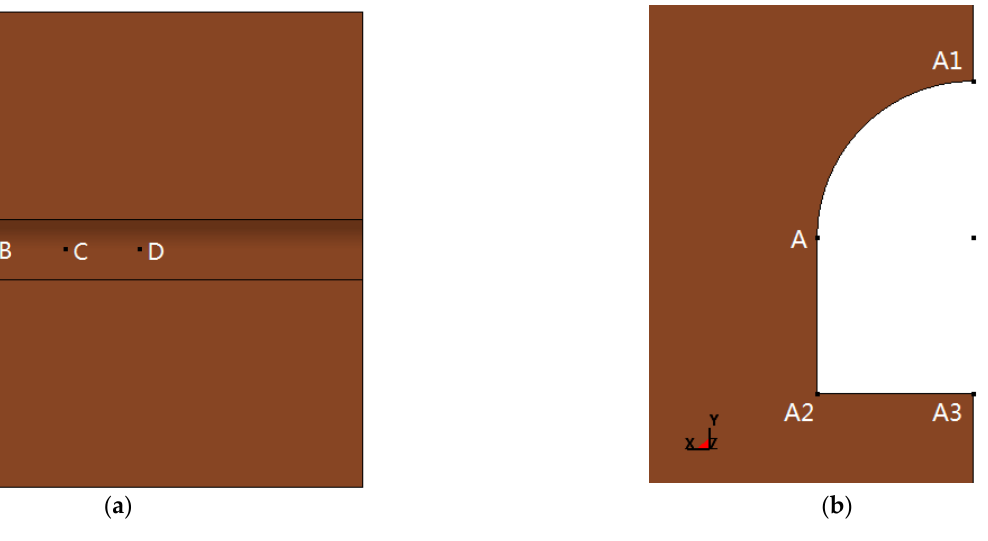
Figure 4. Positions of measuring points. ( a ) Wall measuring point of roadway axis and ( b ) Wall measuring point of roadway section.